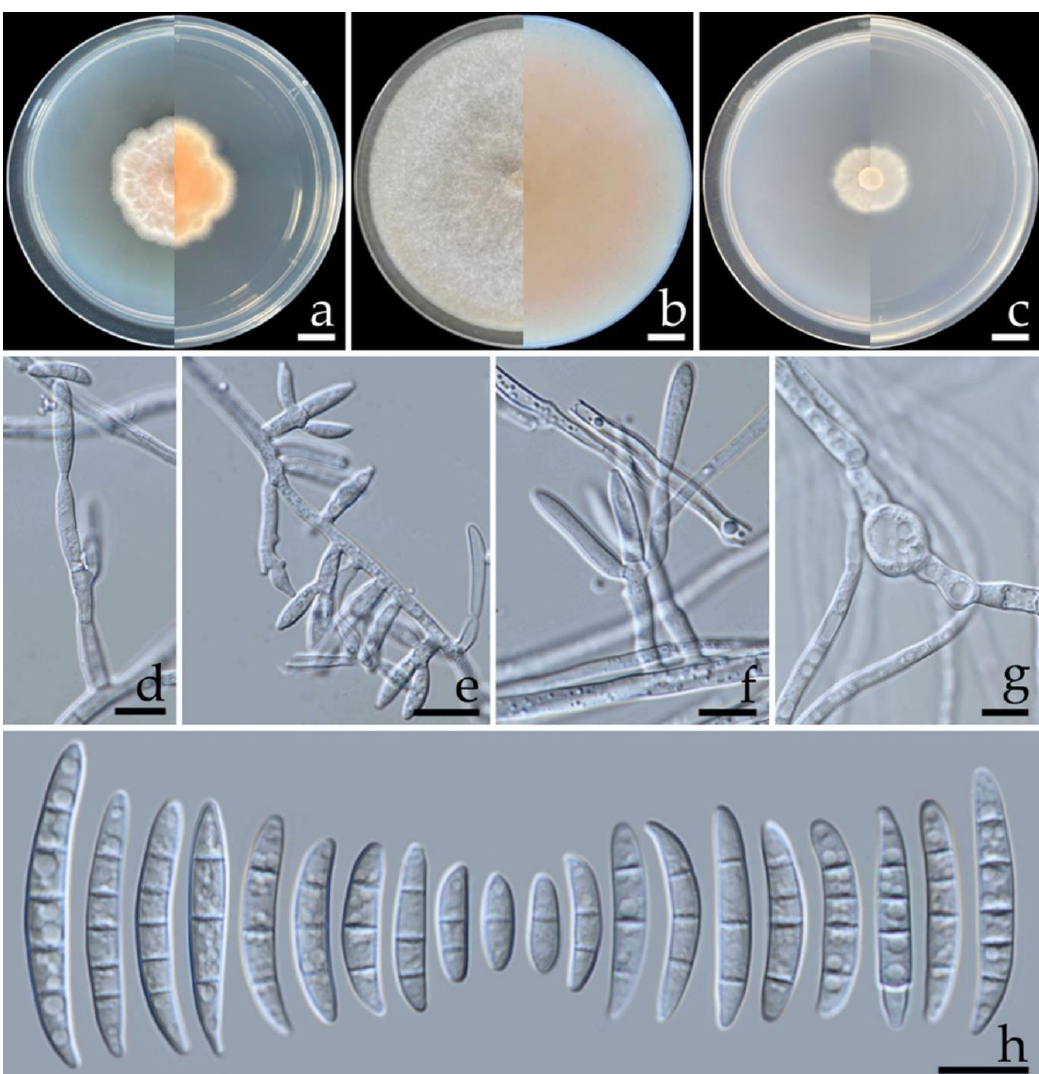
Figure 4. Fusarium melonis (SDBR-CMUS424; holotype). Colonies incubated at 25 °C for one week on PDA ( a ), OA ( b ), and SNA ( c ) (left, surface view and right, reverse view). Conidiophores on aerial mycelium ( d ). Mono- and polyphialides on aerial mycelium ( e ). Polyphialides on aerial mycelium ( f ). Chlamydospores ( g ). Aerial conidia ( h ). Scale bars: a – c = 10 mm; d – h = 10 µm.